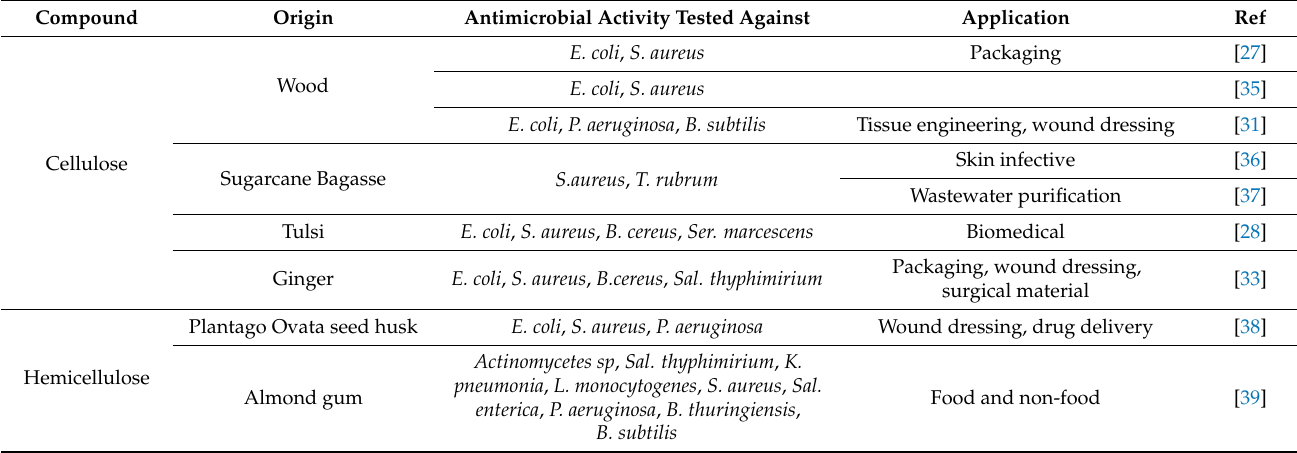
Table 1. Antimicrobial activity of lignocellulosic compounds.